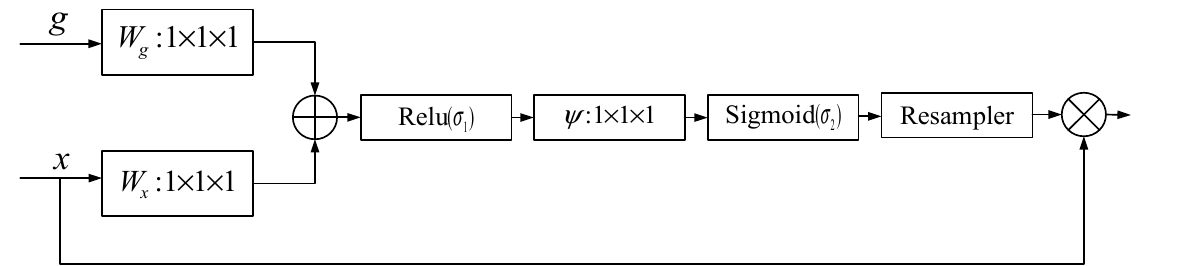
Figure 5. AG module structure diagram.